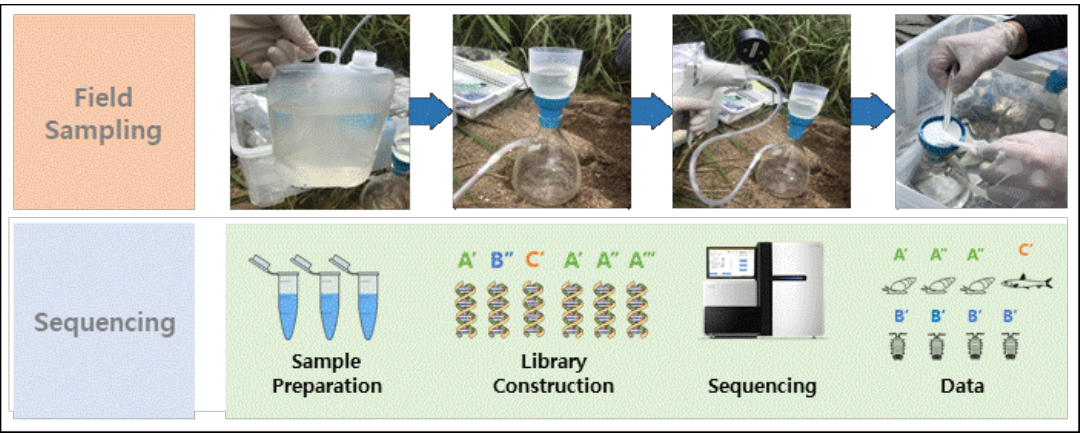
Figure 2 . Analytical procedure of environmental DNA (eDNA) extraction and metagenomic Figure 2. Analytical procedure of environmental DNA (eDNA) extraction and metagenomic sequencing.